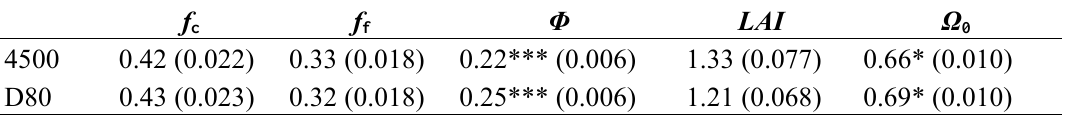
Table 7. Mean and standard error (in brackets) of crown cover ( f crown porosity ( Φ ), LAI and zenithal clumping index ( Ω obtained from DCP with either the 3.9 megapixel Nikon Coolpix 4500 or the Nikon D80 DSLR . Data from the D80 are the average of medium (5.6 megapixel) and small (2.5 megapixel) JPEG images. Asterisks indicate means for the 4500 that differed from those of the D80.